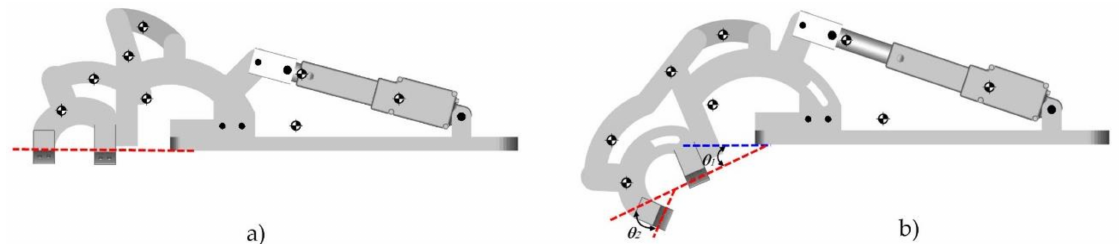
Figure 6. Simulation results for the proposed exoskeleton: ( a ) initial position and ( b ) final position.